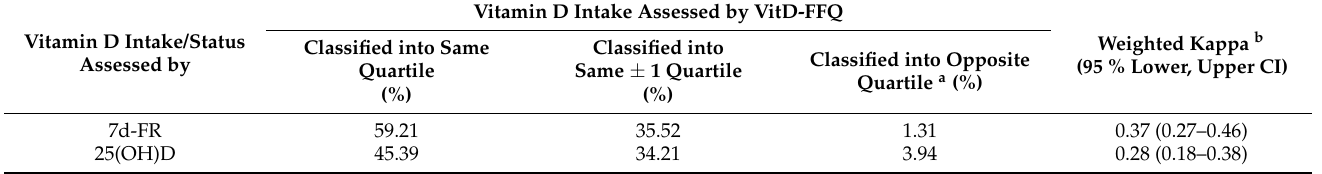
Table 7. Cross-classification of vitamin D intake into quartiles by VitD-FFQ and validation methods (7d-FR and